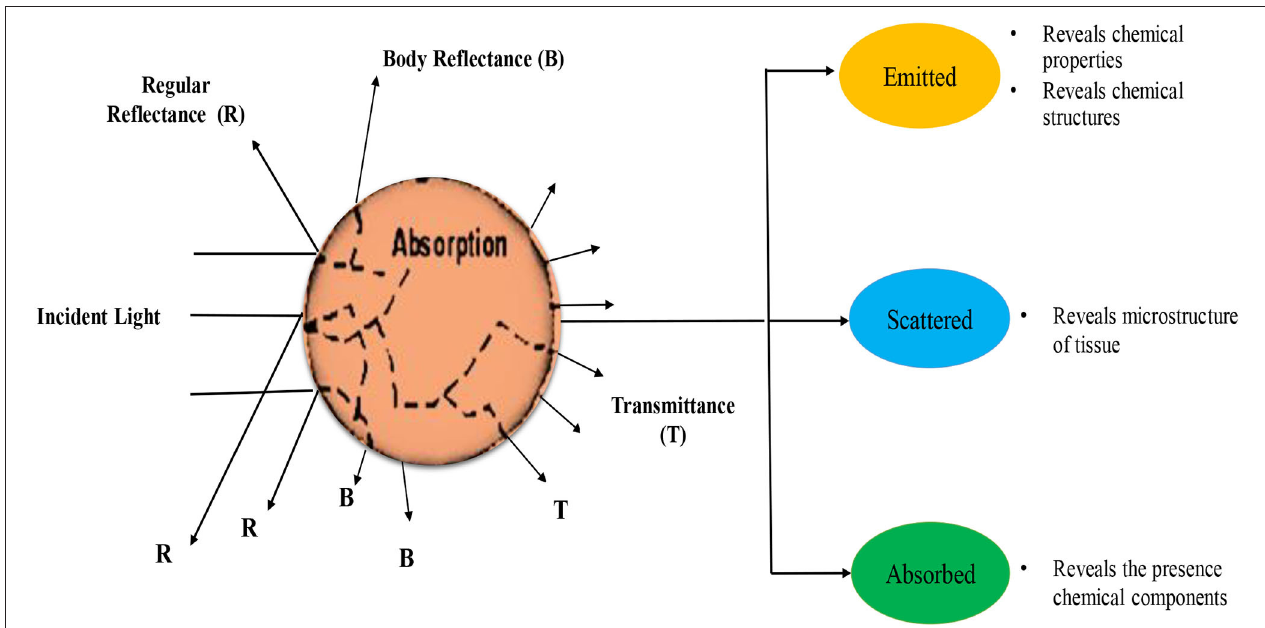
FIGURE 3 | A fundamental concept of near-infrared